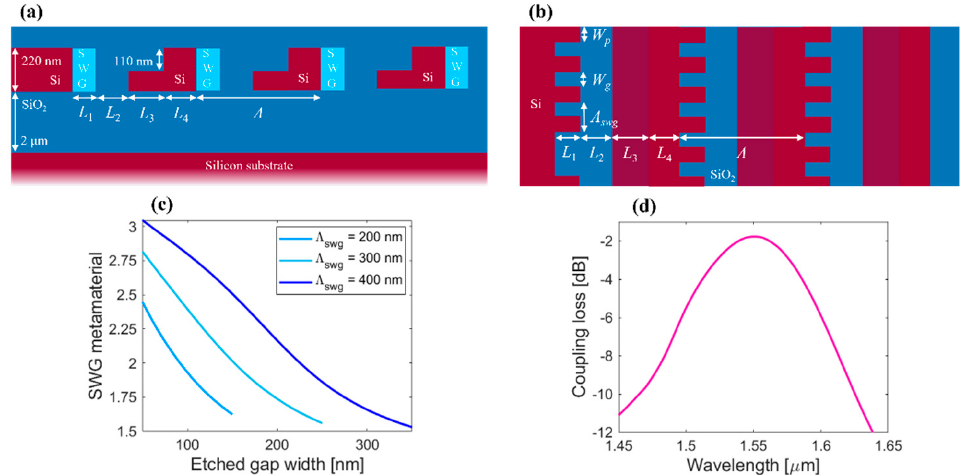
Figure 2. 2D schematics of the central grating coupler with L-shaped SWG-engineered radiating segments in ( a ) side view and ( b ) top view. ( c ) The effective index of the SWG waveguide ( n swg ) as a function of the etched gap width ( W g ) for different subwavelength grating periods ( Λ swg ) of 200 nm, 300 nm, and 400 nm. ( d ) Calculated fiber-chip coupling efficiency of the central grating coupler as a function of the wavelength.